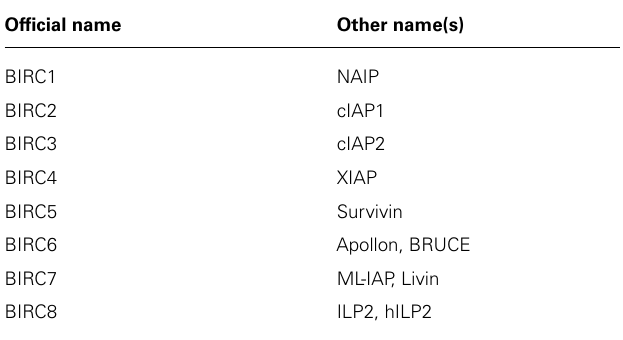
Table 1 | List of human IAP